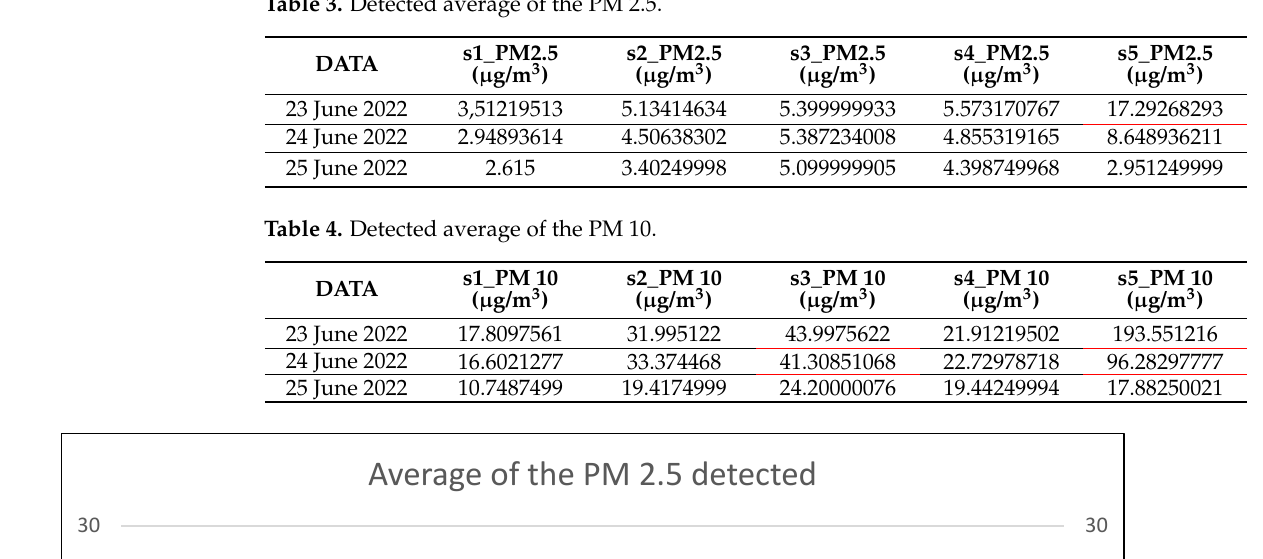
Table 3. Detected average of the PM 2,5.